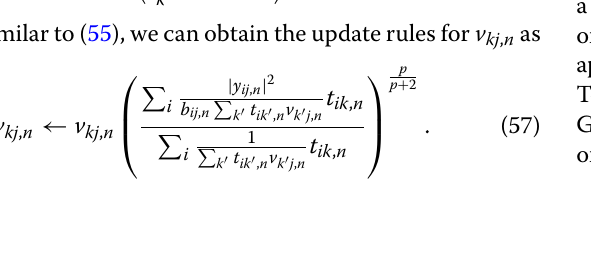
Table 7 Overall average SDR improvements (dB) in two-source case with various signal lengths for the best parameter settings Source and signal length ILRMA